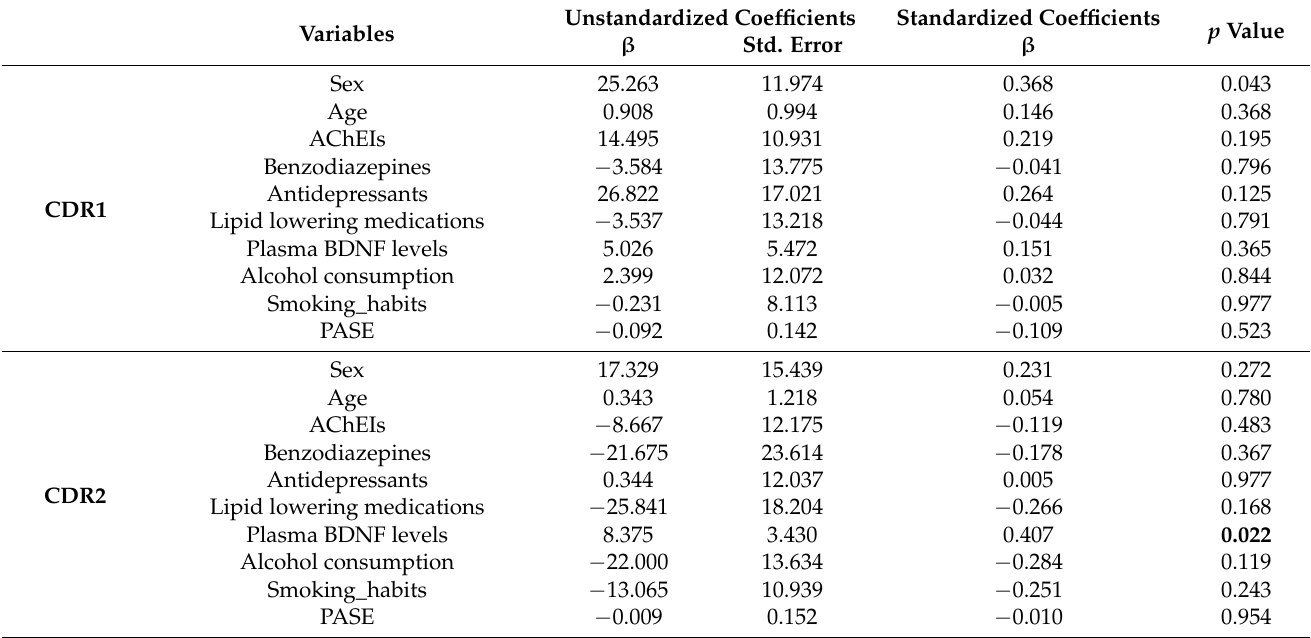
Figure 1. Blood bacterial DNA (BB-DNA) and plasma BDNF levels from elderly controls (EC), and mild cognitive impairment (MCI) and Alzheimer’s disease (AD) subjects. AD and MCI patients had significantly higher baseline BB-DNA and plasma BDNF levels as compared to EC. ANCOVA analysis and generalized linear models (linear model with log-transformed values and identity link-function) correcting for age, sex, education, previous ictus and peripheral artery disease and drug use were applied. * p < 0.05, ** p < 0.01 as compared to EC. Table 2. Multivariate linear regression analysis for variables independently associated with blood bacterial DNA (BB-DNA) in Alzheimer’s disease patients stratified by Clinical Dementia Rating scale